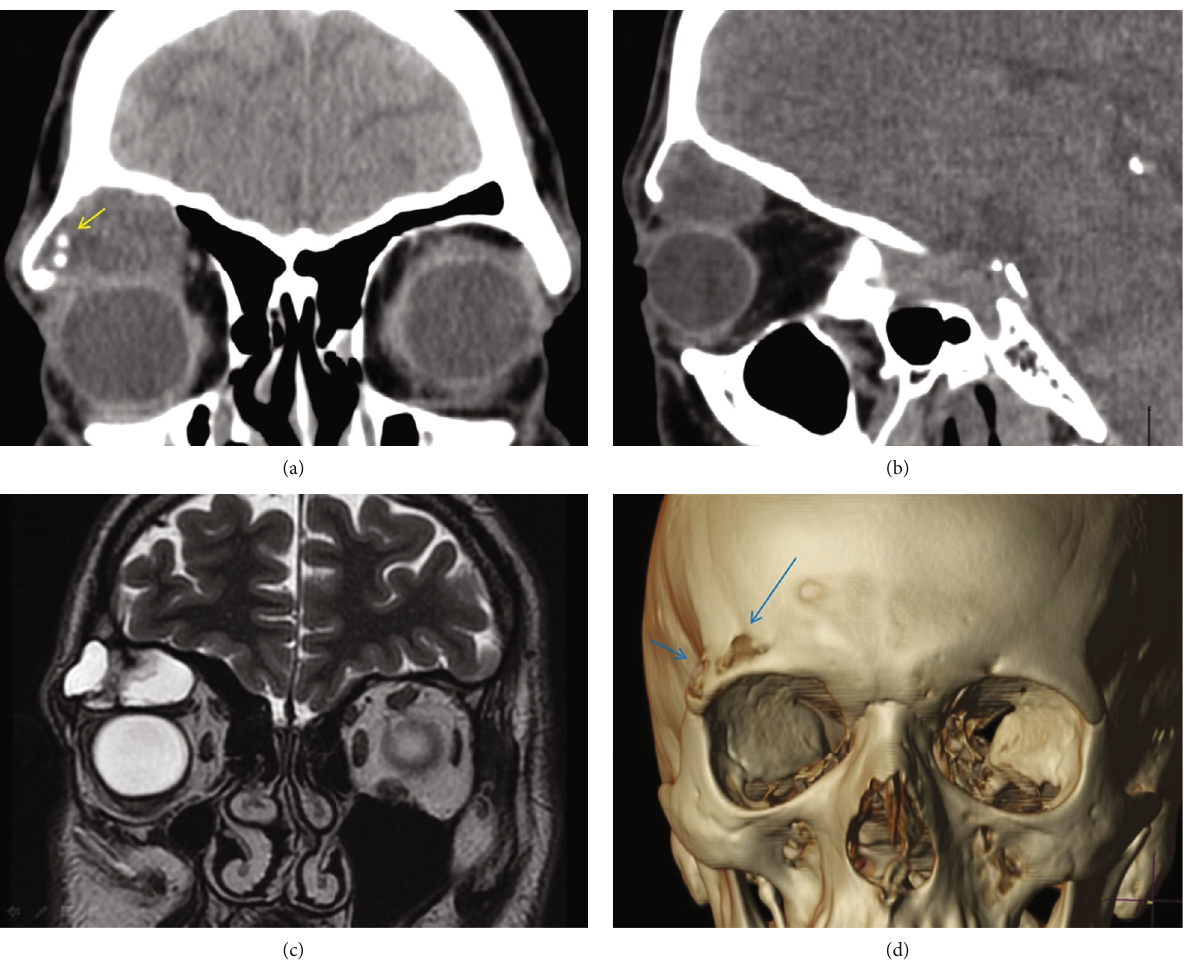
Figure 3: (a, b) Coronal and sagittal CT images, demonstrating an expansive lesion arising from the roof of the right orbit with soft tissue attenuation. Small foci of mineralization (arrow) into the lesion are presented. The lesion protrudes into the orbit. (c) Coronal T2- weighted MR image shows a well-de fi ned lesion arising from the bone with an extraosseous component. The majority of the tumor has high signal intensity on the T2-weighted image, with low signal areas which represent the solid component of the tumor. (d) Volume- rendered 3D-CT reconstruction images show lytic areas with bone destruction in the roof of the